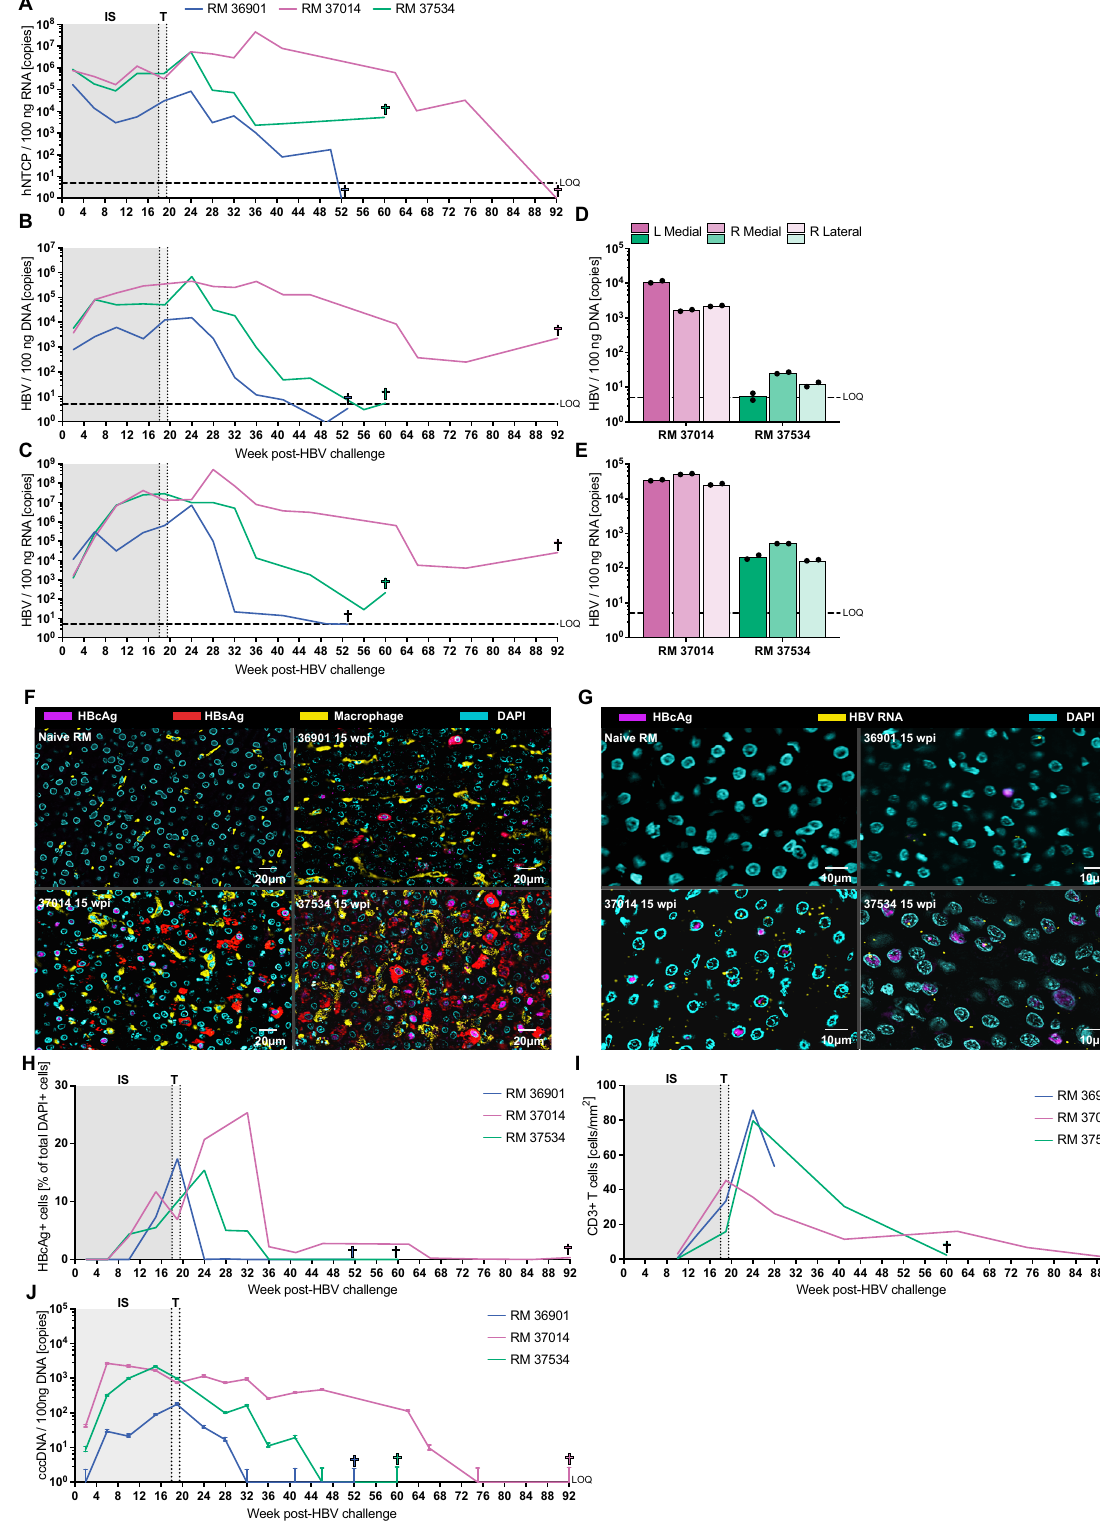
Fig. 4 Assessment of HBV infection in RM livers. A hNTCP expression in the liver is consistent over time following HBV infection. B HBV DNA levels are consistent over time following HBV infection. C HBV expression is consistent over time following HBV infection. D Distribution of HBV DNA in the liver lobes at euthanasia. E Distribution of HBV RNA in the liver lobes at TOD. F Immuno fl uorescence shows wide-spread HBc (green) and HBs (red) infection of hepatocytes, but not Kupffer cells (yellow). G Dual fl uorescent RNAScope-IHC staining shows HBV RNA (red) and HBcAg expression (green) in the liver of infected RM. H Frequency of HBcAg-positive nuclei in the liver of HBV-infected RM. I Quanti fi cation of CD3 + T cells in the liver of HBV-infected RM. J cccDNA levels in RM liver following HBV infection. Data are presented as mean values + / − SD. Three independent experiments were conducted for panels F-G with similar results. Source data are provided as a Source Data fi